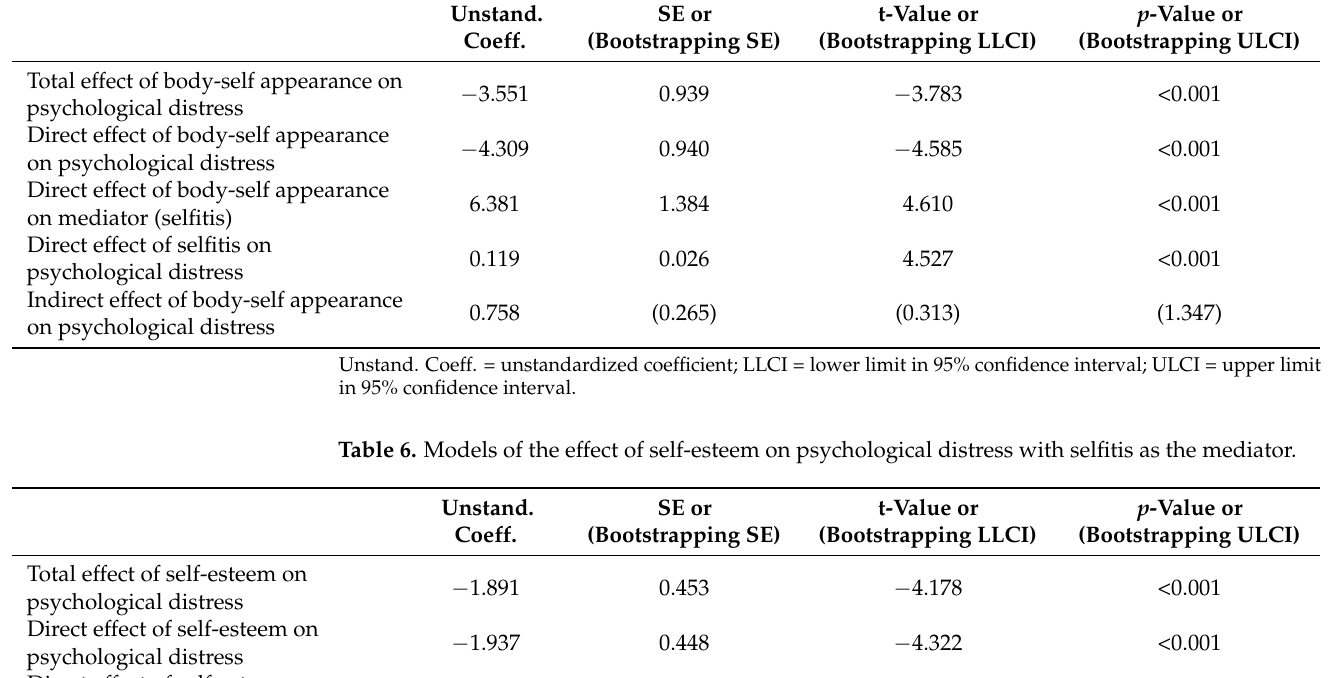
Table 5. Models of the effect of body-self appearance on psychological distress with selfitis as the mediator. Unstand. SE or t-Value or Coeff. (Bootstrapping SE)